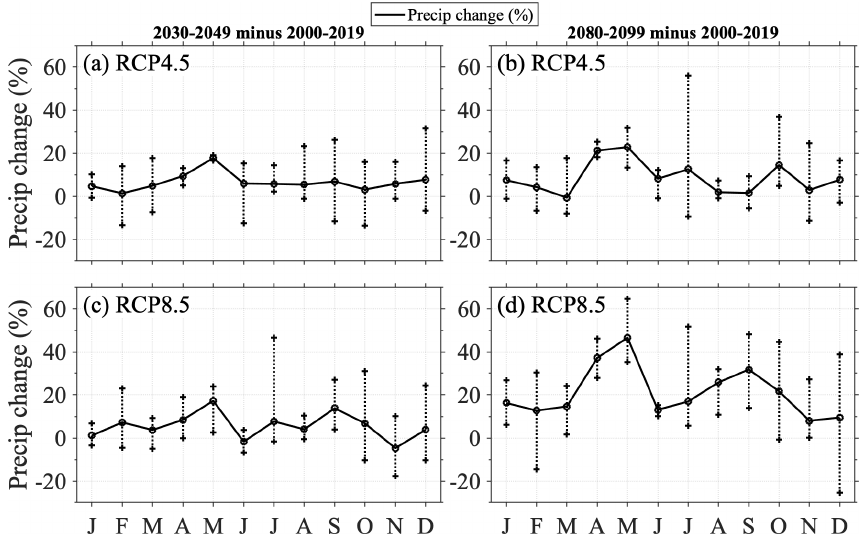
Figure 9. Projected changes in monthly precipitation over the Great Lakes basin in the mid-century (2030–2049) and late century (2080– 2099) for the RCP 4.5 (a, b) and RCP 8.5 (c, d) scenarios relative to the present-day climate (2000–2019). Vertical error bars indicate the range of the three individual GLARM projections.